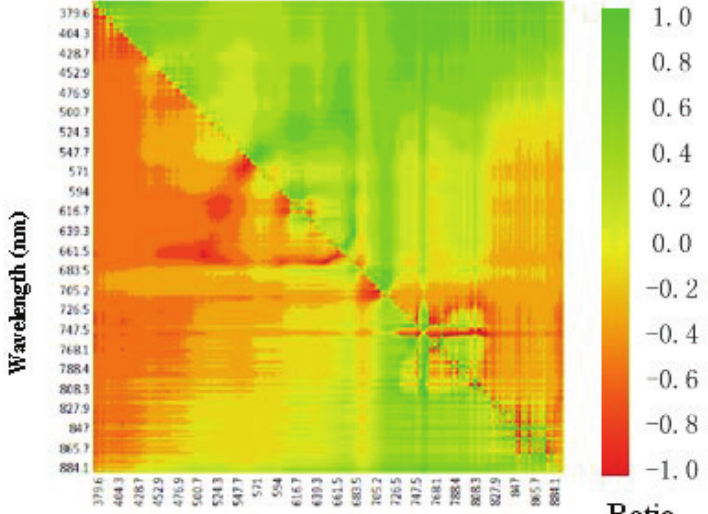
Figure 7. The correlation coefficients between Chl- a and reflectance